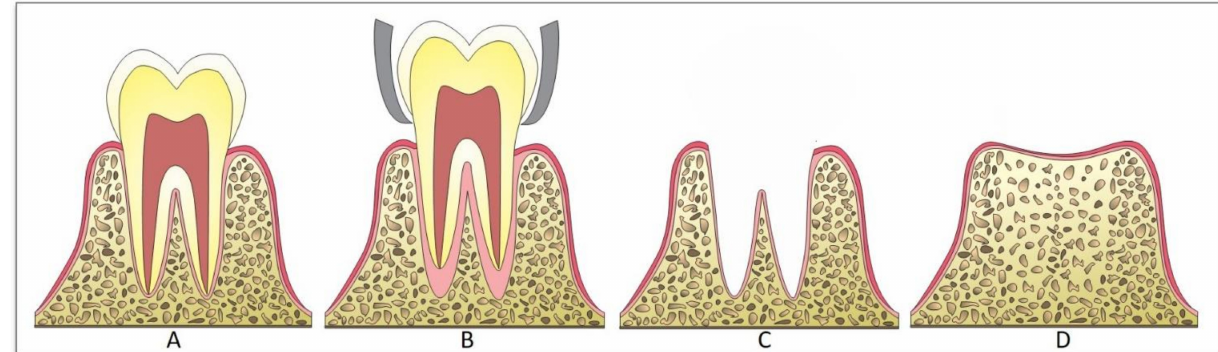
Figure 1. Diagram showing the change in the volume of the alveolar bone ridge due to bone loss before tooth extraction. ( A ) Proper dental implantation. ( B ) Alveolar bone loss due to periodontal disease. ( C ) Bone condition after tooth extraction. ( D ) Alveolar bone healing.